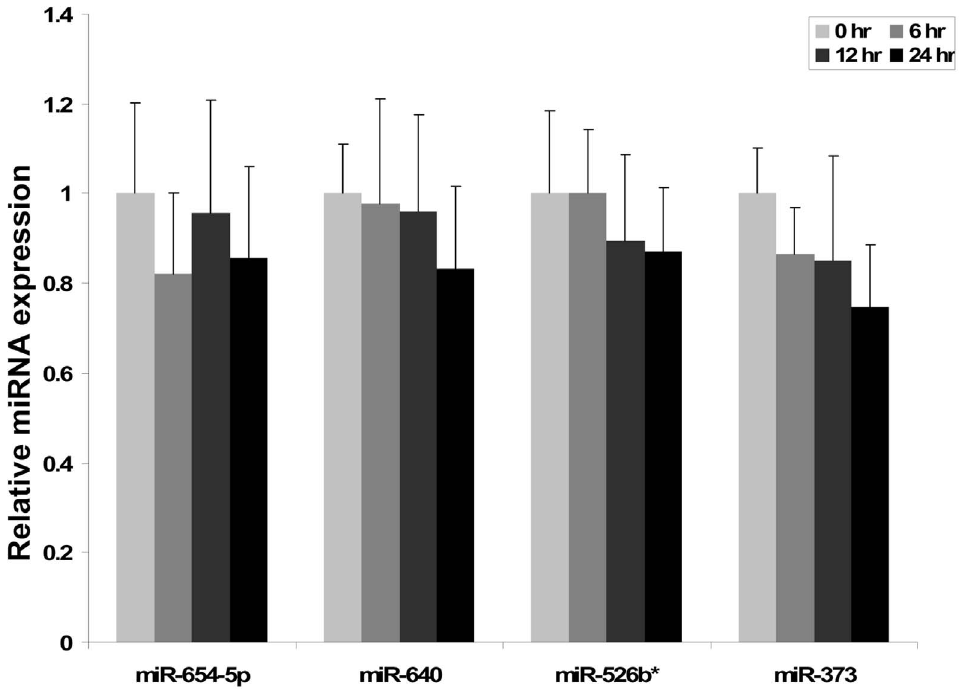
Figure 5. Stability of exosomal miRNAs under invitro culture conditions. Exosomes, isolated using differential ultracentrifugation from follicular fluid, were incubated under in vitro cell culture conditions (37 u C & 5% CO 2 ) for 6 hr, 12 hr and 24 hr in a exosome-free culture medium in order to determine the stability of exosomal miRNAs by quantitative real time PCR. Non-cultured exosomes (0 hr) were used as reference controls to check the stability of exosomes coupled miRNAs in different time point. The data is presented as means and SD of three biological replicates.